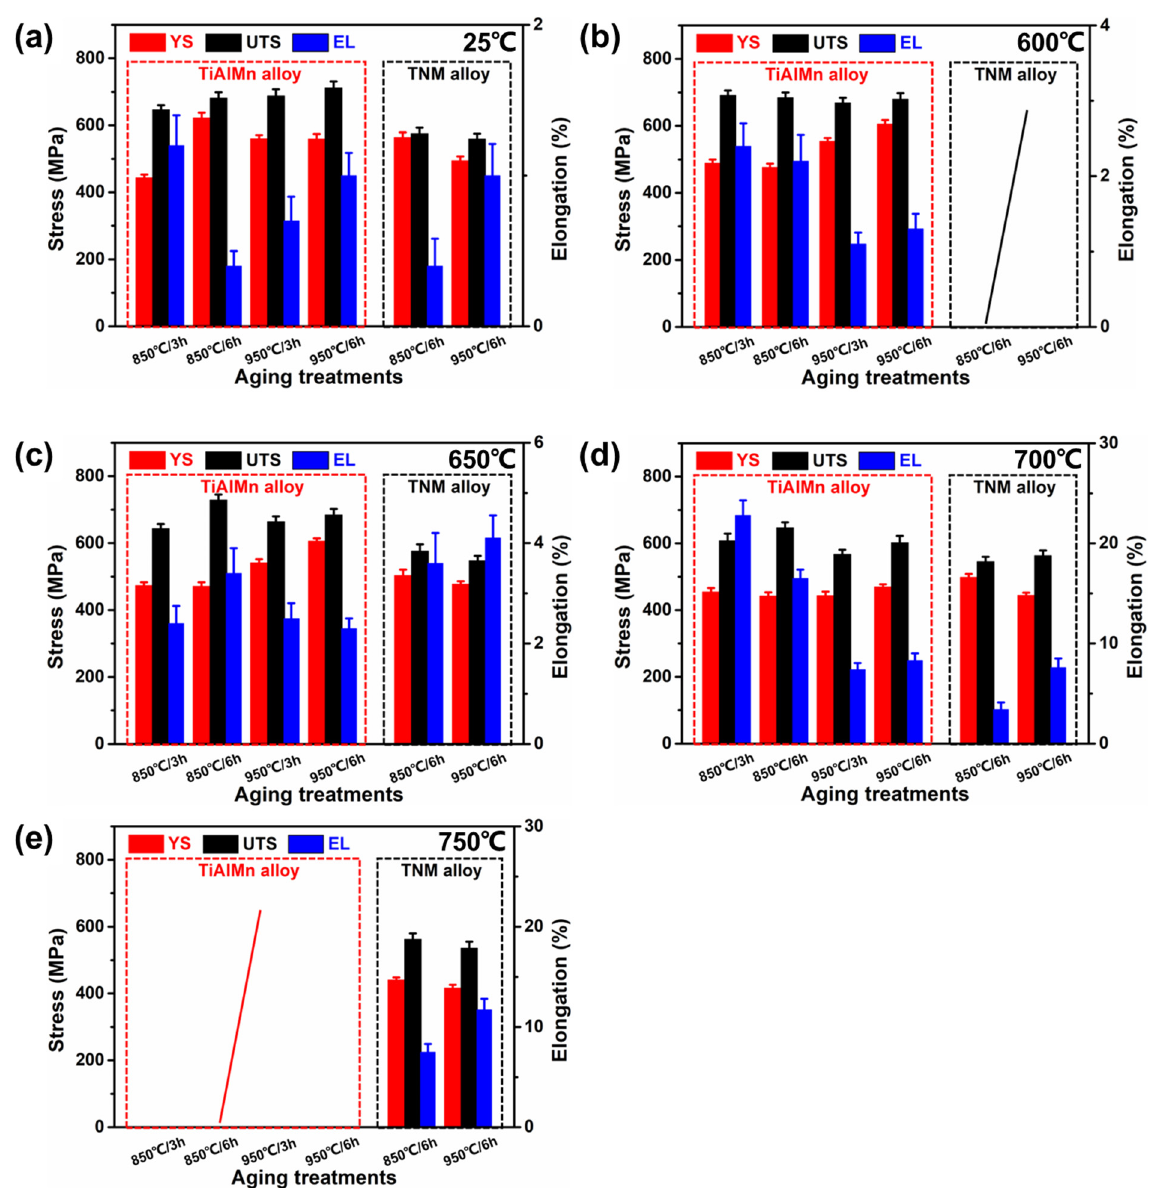
Figure 9. The tensile properties of the TiAlMn alloy and TNM alloy after different aging treatments as a function of the testing temperature: ( a ) 25 °C, ( b ) 600 °C, ( c ) 650 °C, ( d ) 700 °C , ( e ) 750 °C. Table 4. Summary of the tensile properties of the heat-treated TiAlMn alloy and TNM alloy at dif- ferent temperatures in Figure 9.